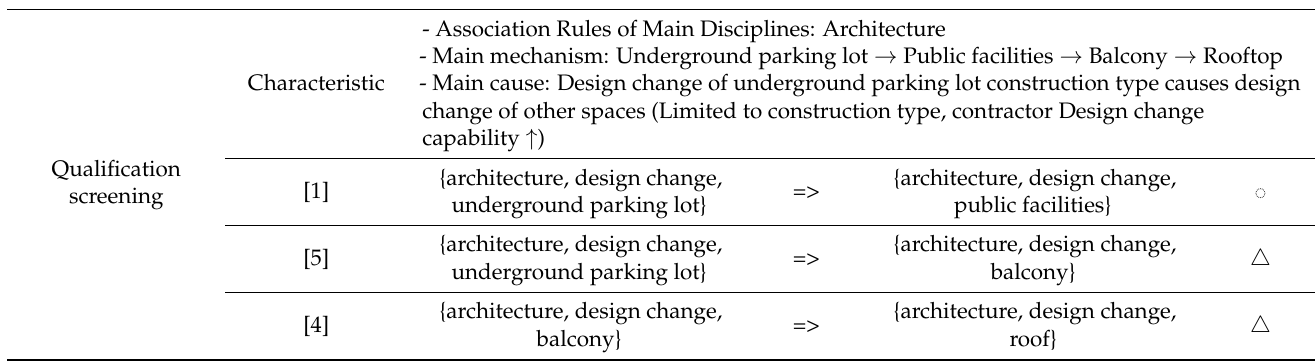
Table 3. Association rule classification system through expert